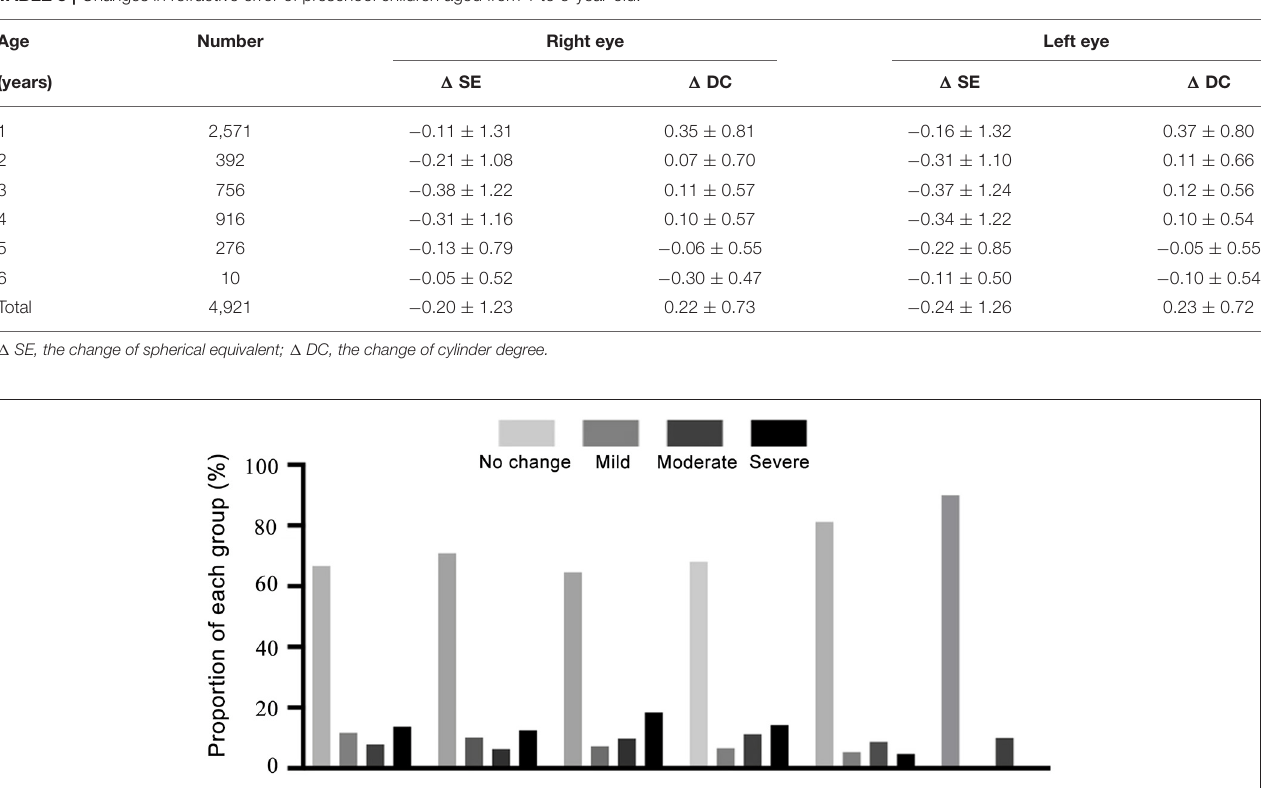
TABLE 3 | Changes in refractive error of preschool children aged from 1 to 6-year-old.